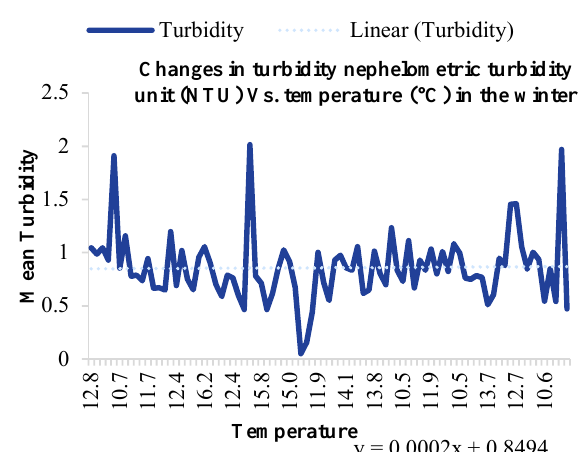
Figure 4. Residual chlorine fluctuation in spring The average amount of turbidity measured